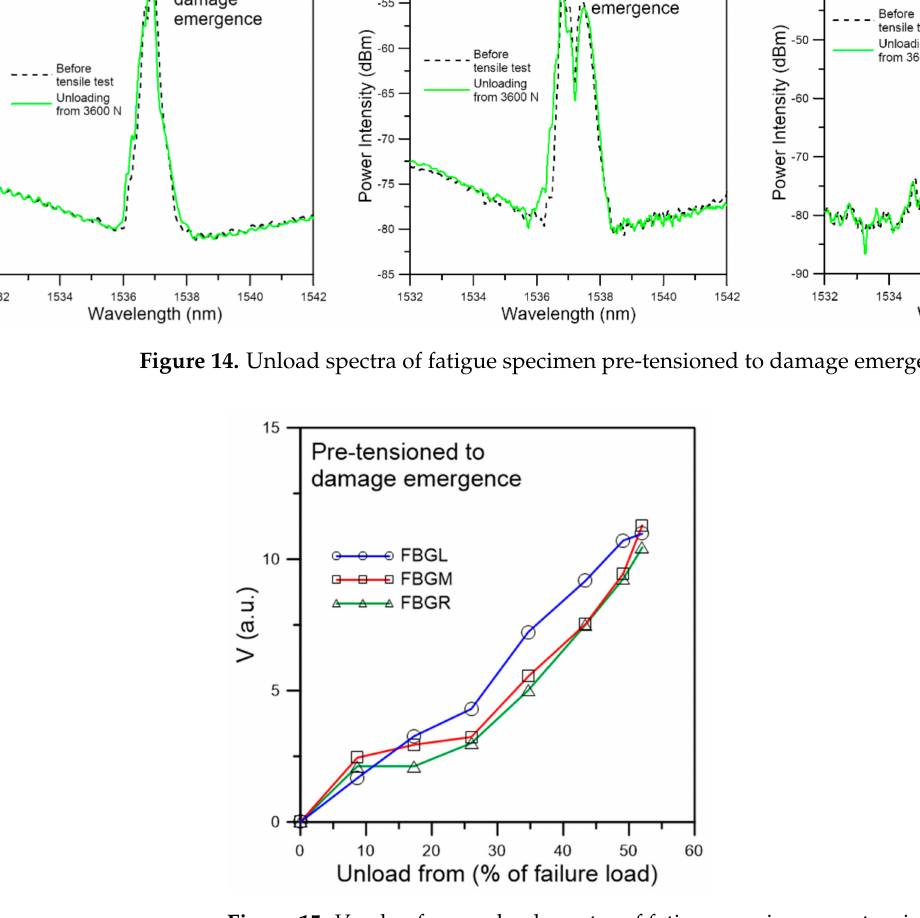
Figure 15. V value from unload spectra of fatigue specimen pre-tensioned to damage